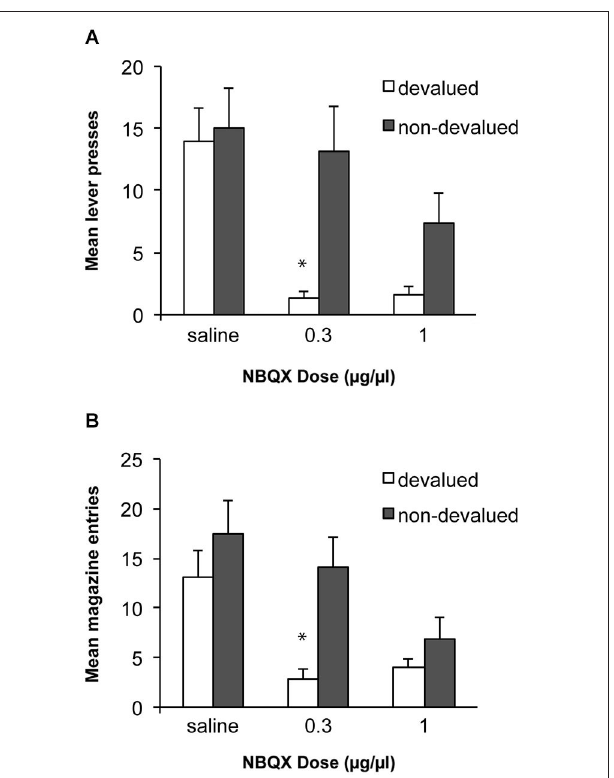
FIGURE 3 | Effects of NBQX infusion into the DLS on sensitivity to outcome devaluation . (A) Following 8 weeks of ethanol self-administration lever-press responding was insensitive to devaluation following saline infusions. Infusion of 0.3 µ g/ µ l NBQX restored sensitivity to devaluation. Infusion of the higher dose (1.0 µ g/ µ l) produced a marginal devaluation effect but overall responding was also lower. *